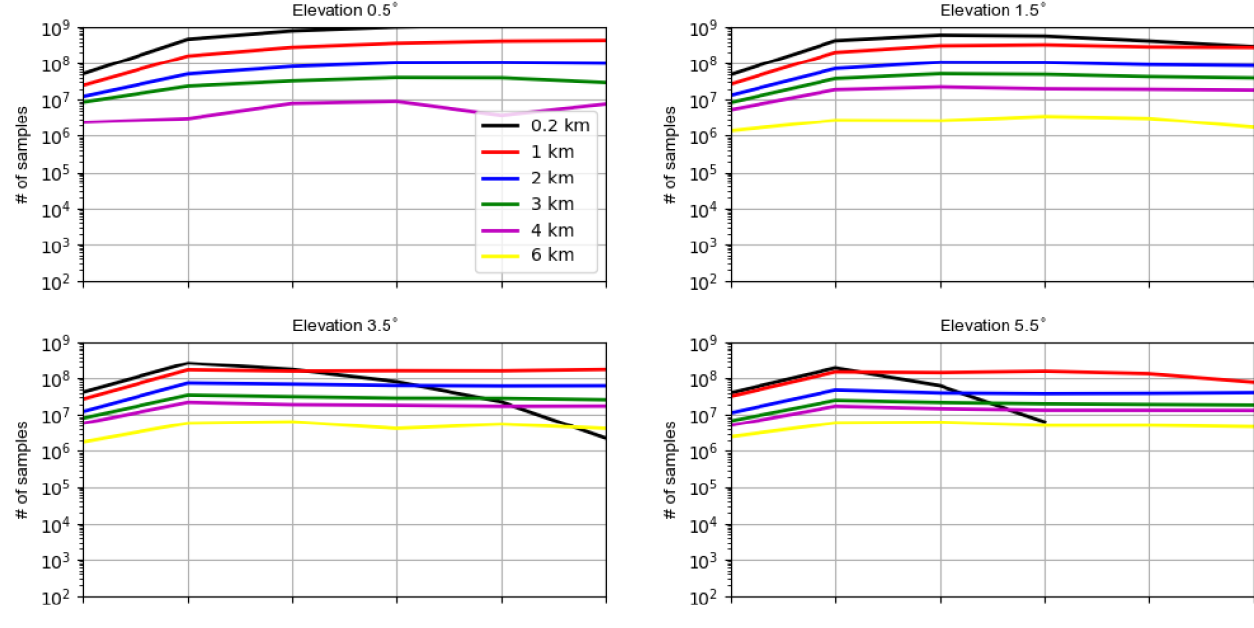
Figure A3. The same as Fig. A2 but for radial wind data.